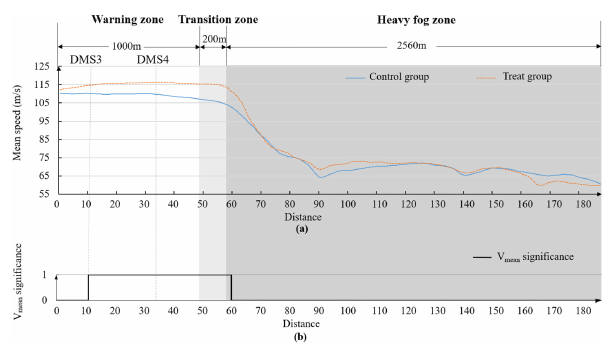
Figure 6 Effect of the fog warning system on speed